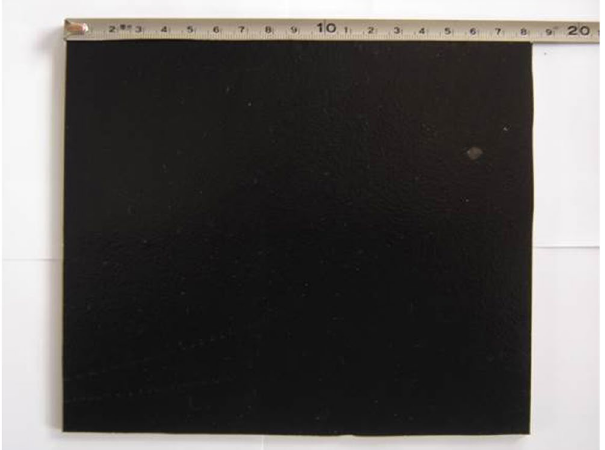
Figure 2. The coating samples were painted onto the 180 mm × 180 mm standard aluminium plate.